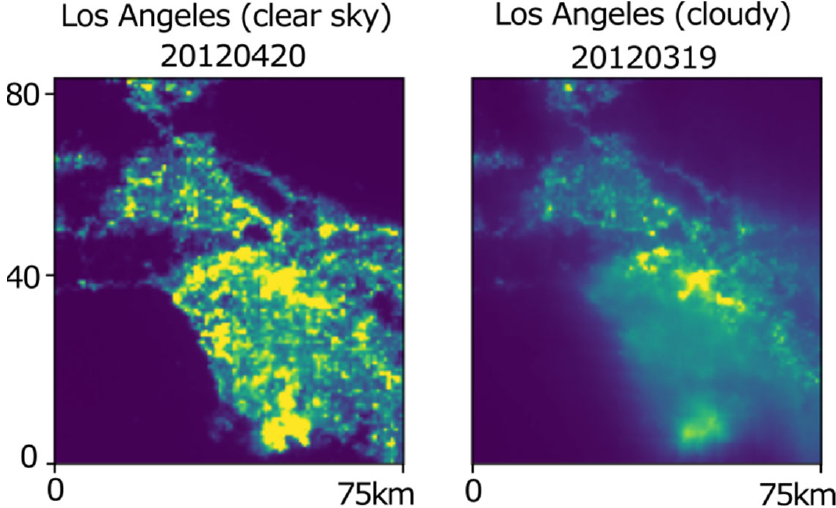
Figure 3. Clear vs. cloudy VIIRS/DNB night light image samples over Los Angeles show dissimilar patterns (unit: km).